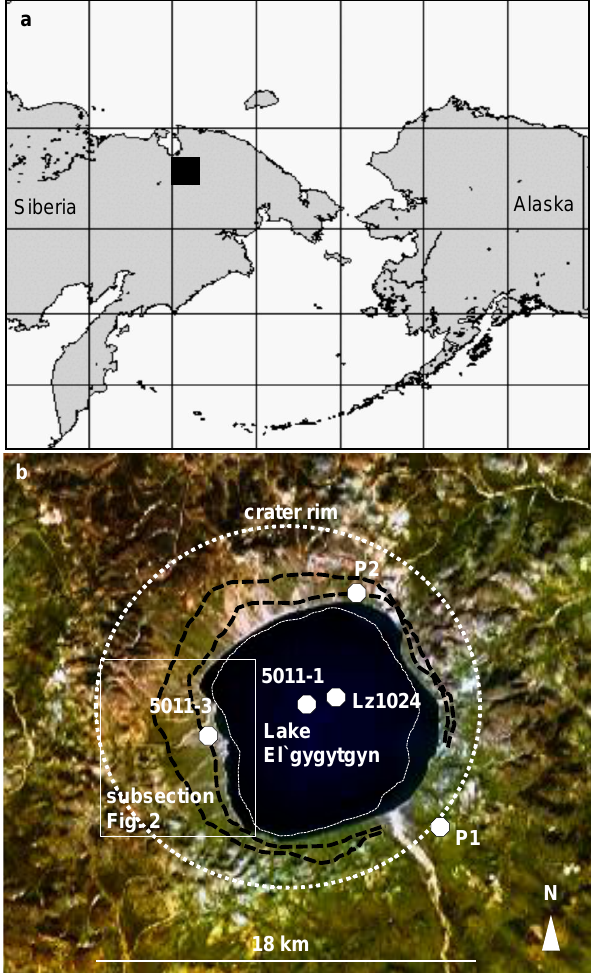
Fig. 1. (a) Geographic position of the El’gygytgyn Crater in NE Russia (black box). (b) A Landsat image showing the crater (dot- ted line) and drill site 5011-3. 5011-1, Lz1024, P1 and P2 denote for other cores discussed in the text. The lake is east of the crater centre and semi-surrounded by a flat permafrost surface to the west and north. The dashed black lines indicate shorelines of the Mid- dle Pleistocene (outer) and the Late Pleistocene (inner) according to Glushkova and Smirnov (2007). The dashed white line marks the lake level during the LGM according to Juschus et al.